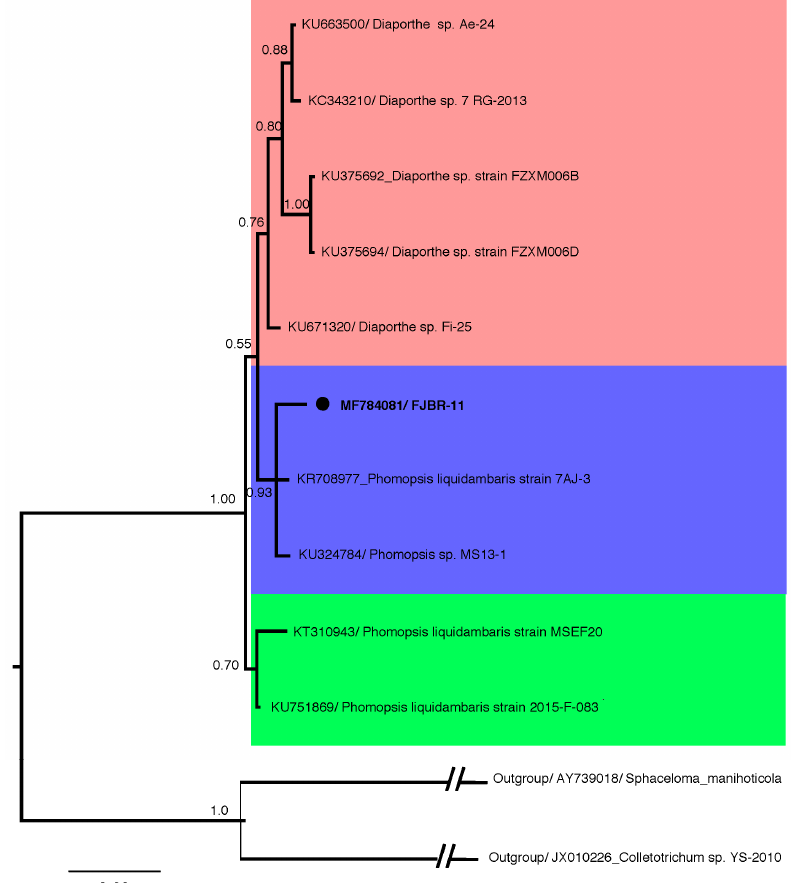
Figure 1. Phylogenetic relationship of isolate FJBR-11 (accession no. MF784081) to representative sequences of known Phomopsis sp. and Diaporthe sp. Reference sequences were retrieved from GenBank and a Sphaceloma sp. and a Colletotrichum sp. served as an outgroup. The isolate FJBR-11 from the current study is marked with a black dot. The distance unit is substitutions/site.